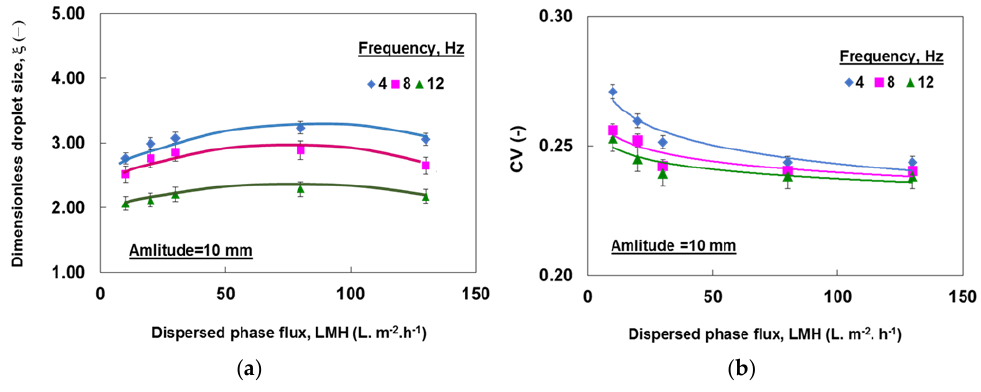
Figure 7. Effect of dispersed phase flux and oscillation frequency on ( a ) droplet size and ( b ) size distribution.